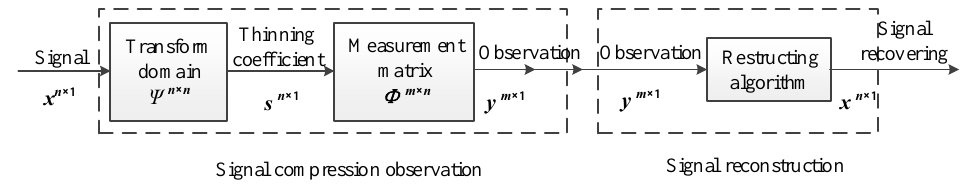
Figure 2. Compression sensing code block diagram.